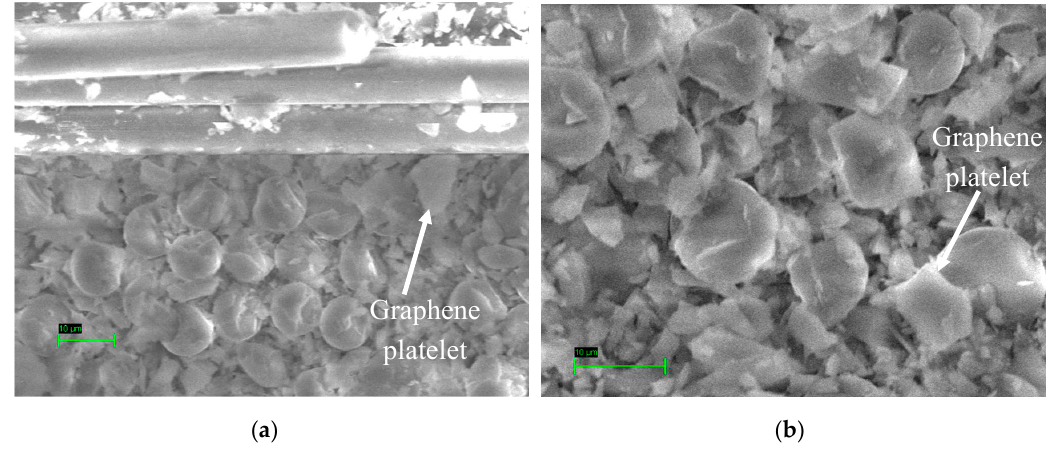
Figure 10. SEM images of graphene coated glass fiber composites at two different magnifications. ( a ) low magnification; ( b ) high magnification.